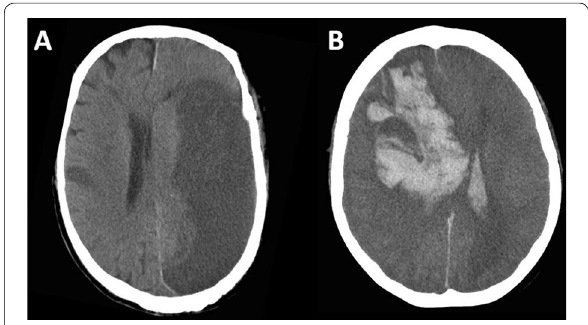
Fig. 2 Brain CT‑scan showing ECMO‑related A massive cerebral infarction and B intraparenchymal hemorrhage